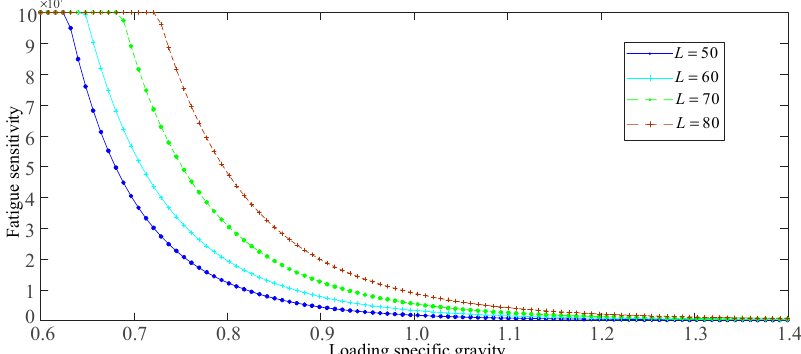
Figure 19. Effect of loading specific gravity on the fatigue characteristics of flexible wheels with different cylinder lengths.